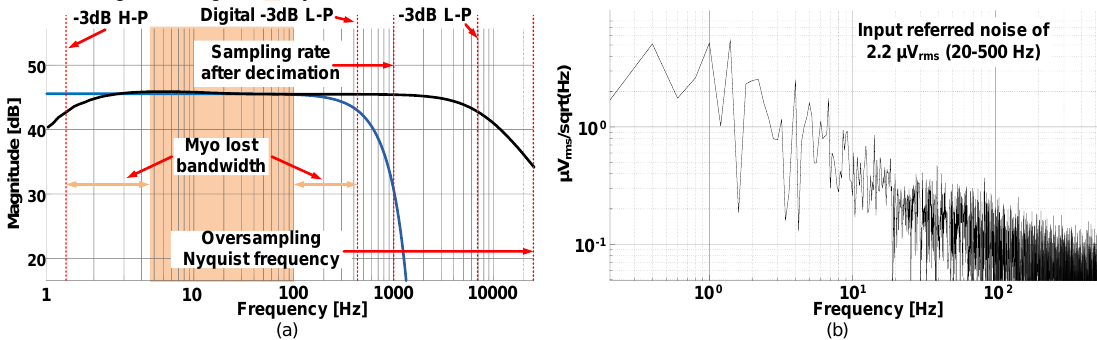
Figure 4. ( a ) Analog bandwidth of the bioamplifier (in black), digital bandwidth of the decimation filter (in blue), Myo bandwidth comparison (in orange), and ( b ) noise spectrum of the bioamplifier. The input referred noise is of 2.5 µ V rms over a 500-Hz